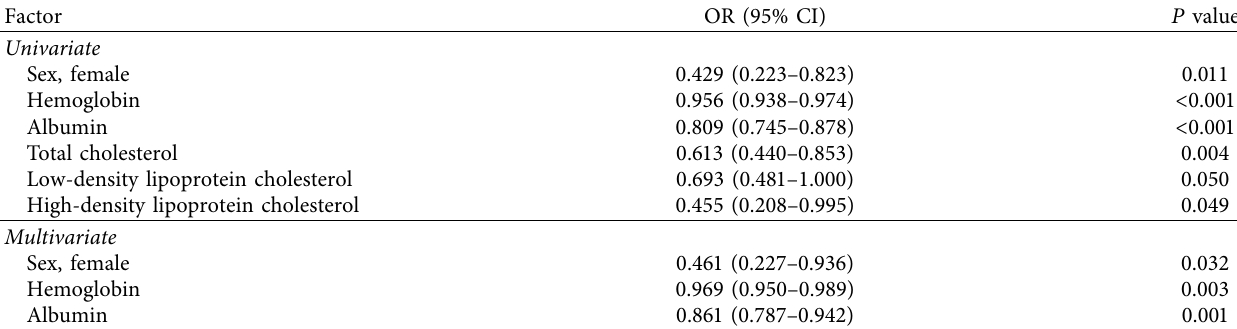
Table 3: Logistic regression analysis: Related factors of readmission attributable to LRTIs within 1 year of discharge. Factor